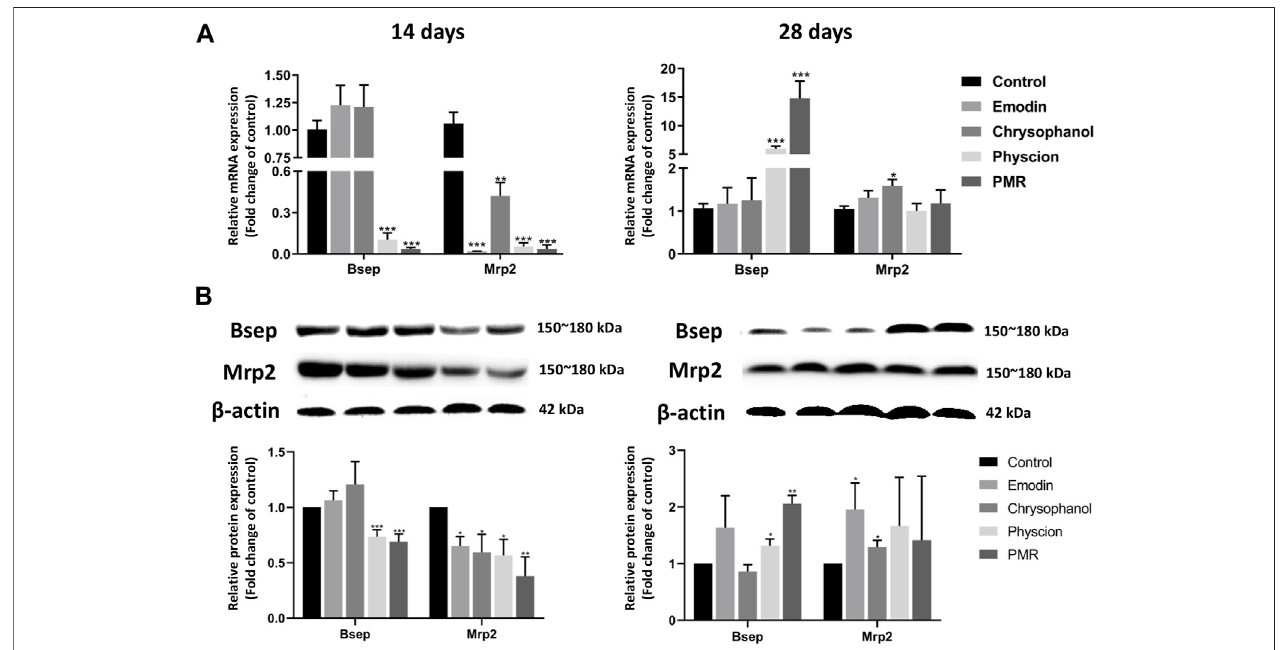
FIGURE7| mRNA (A) and protein (B) expression levels ofBsep and Mrp2 inthe mouse livers. Bar plotswere represented asthe mean ±SD (n=8for quantitative real-time PCR, n = 4 for western blotting using each two samples pooled). * p < 0.05, ** p < 0.01, *** p < 0.001 compared with control group.